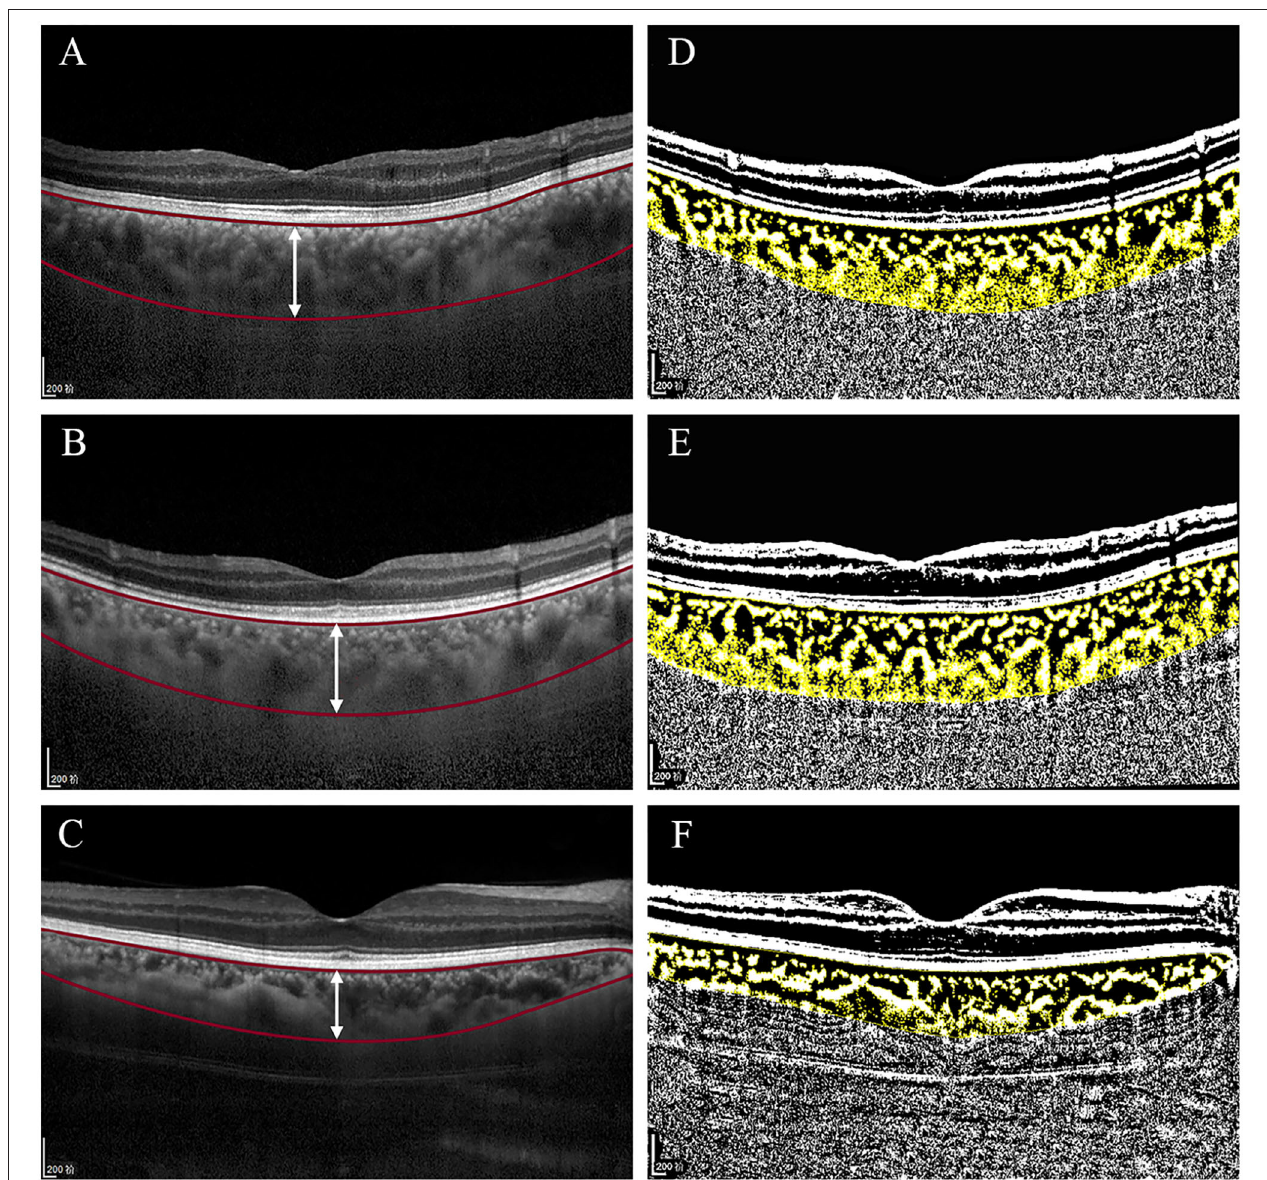
FIGURE 1 | Original spectral-domain optical coherence tomography (SD-OCT) (A-C) and binarized SD-OCT images (D-F) of this study in eyes with malignant glaucoma (MG) group, the fellow eyes with non-MG group, and control eyes with uncomplicated primary angle-closure glaucoma (PACG) group. (A-C) Based on the prebinarized image, two horizontal red lines segment the choroid from Bruch’s membrane to the choroidal–scleral interface. The vertical white line at the fovea was used for calculation of the subfoveal choroidal thickness (SFCT), which measured 485, 489, and 330 µ m. (D-F) Based on the binarized image, the yellow block represents the total choroidal area (TCA), the choroidal vessel lumen area (LA) is represented by dark pixels, and the stromal area (SA) is represented by light pixels. The choroidal vascularity index (CVI) was 61.81, 60.56, and